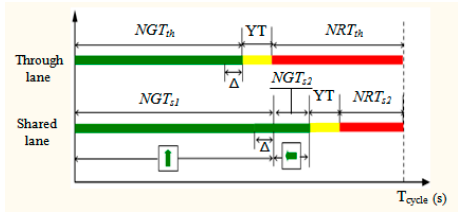
Figure 14. The control phases for the case shown in Figure 10.